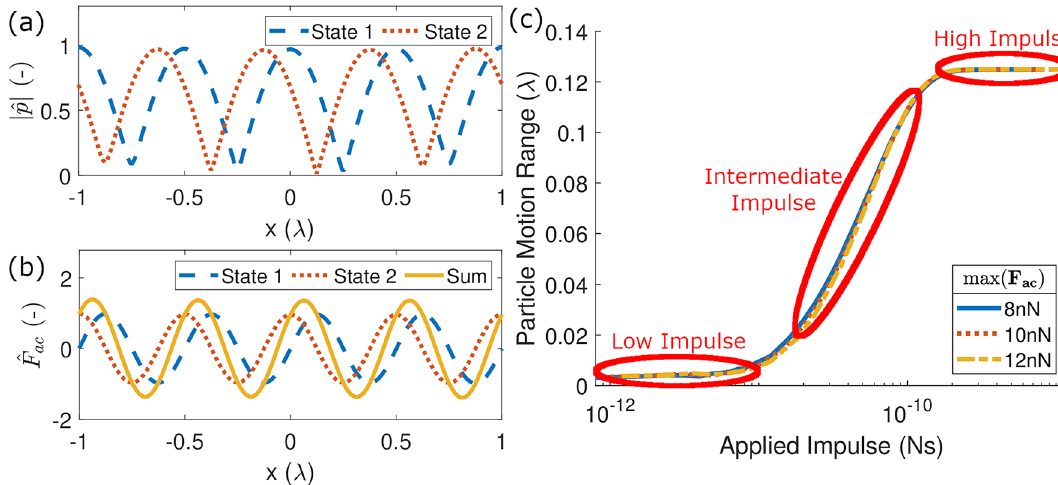
Figure 1. ( a ) The two normalised absolute 1D pressure fields, |ˆ p | , with one source’s phase output offset from the other by π 2 . ( b ) The normalised acoustic forces, ˆ F ac , generated by the pressure fields in ( a ) and the sum of these two fields. ( c ) The variation in particle motion per cycle vs the applied impulse, I app , varied by both the maximum force and the switching time. The different lines indicate different maximum F ac values which the force field was normalised to and each force was applied with a (cid:31) t s range from 0.1 ms up to 100 ms. Note that the lines overlap, indicating that applied impulse produces a consistent effect regardless of which component is